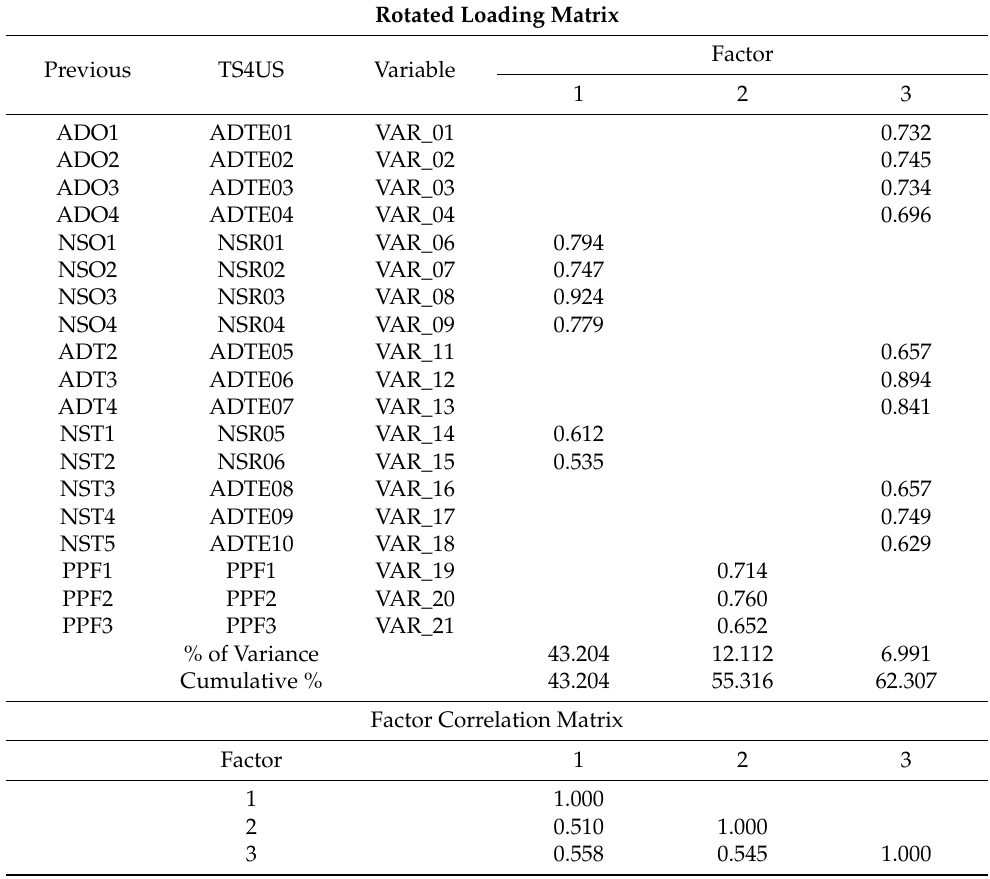
Table 7. Confirmatory Factor Analysis for 3 factors.